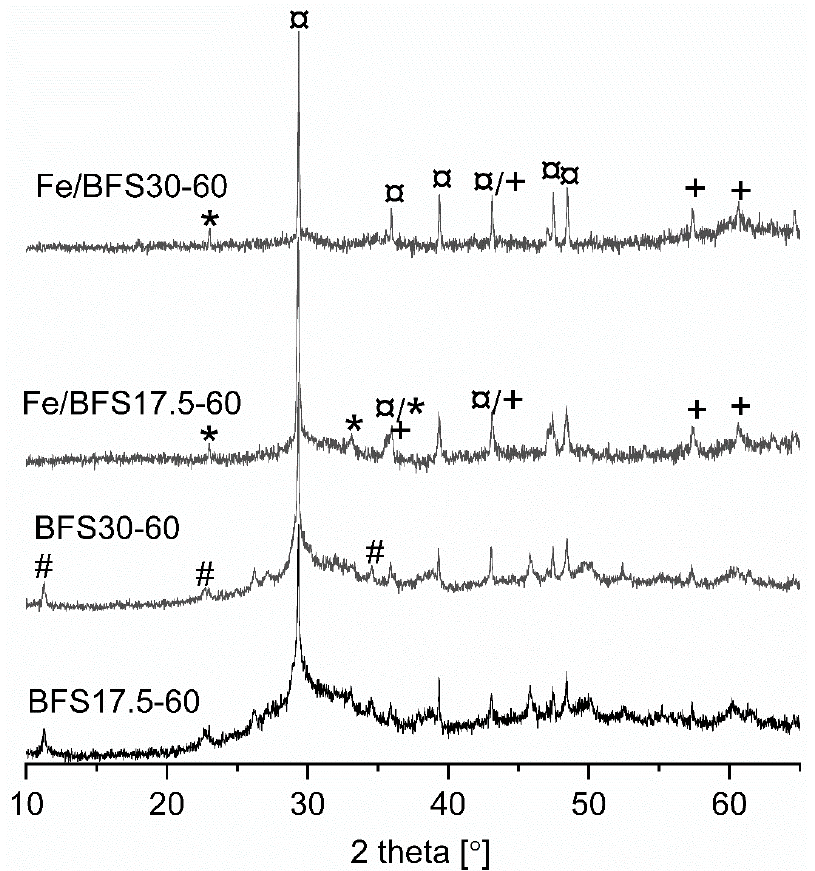
Figure 7. X-ray diffractograms of used BFS17.5-60, BFS30-60, Fe/BFS17.5-60, and Fe/BFS30-60. (#) ICDD file 00-022-0700 (Mg 6 Al 2 CO 3 (OH) 16 · 4H 2 O, hydrotalcite); (¤) ICDD file 01-083-4609 (CaCO 3 ); (*) ICDD file 04-015-7029 (Fe 2 O 3 ); (+) ICDD file 04-008-8146 (Fe 3 O 4 ).